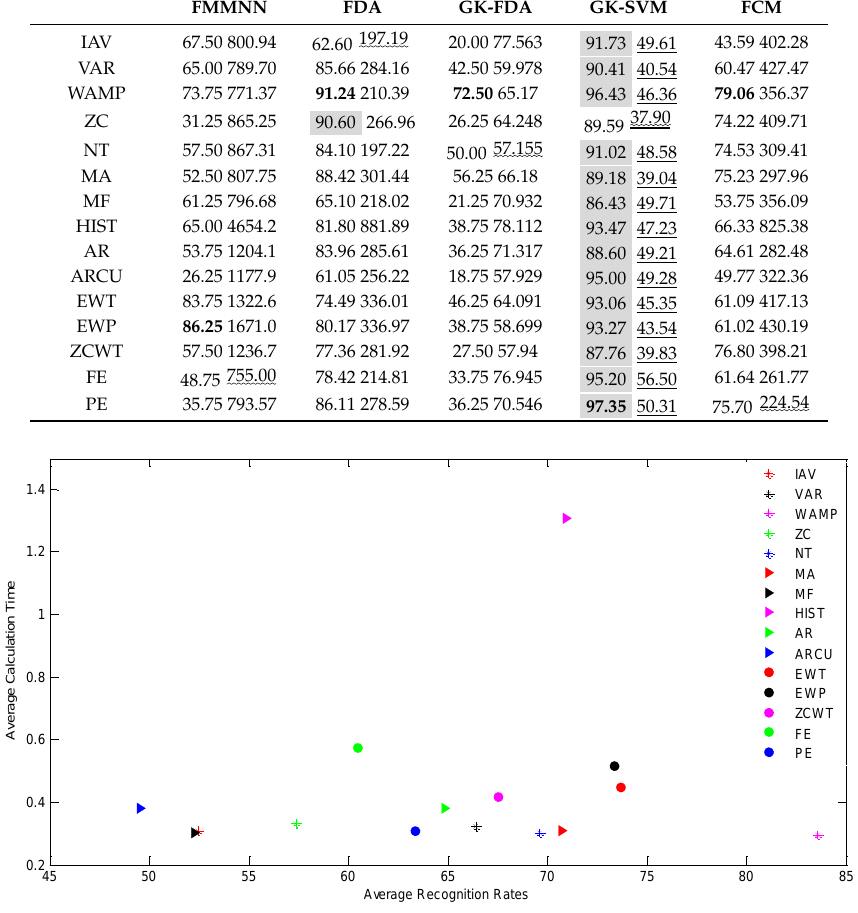
Table 3. Recognition Rates and Calculation Time (%, ms). The bold numbers indicate the features with the highest accuracy rate for each classifier. The shaded numbers indicate the classifiers with the highest accuracy rate for each feature. The zigzag underlines indicate the features with shortest calculation time for each classifier. The straight underlines indicate the classifiers with shortest calculation time for each feature.